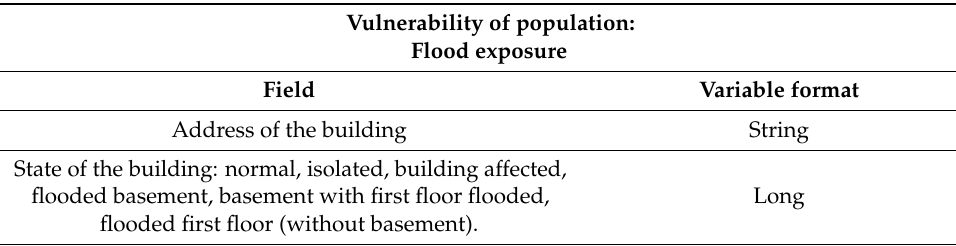
Table 2. Field values and variable format used to develop the story